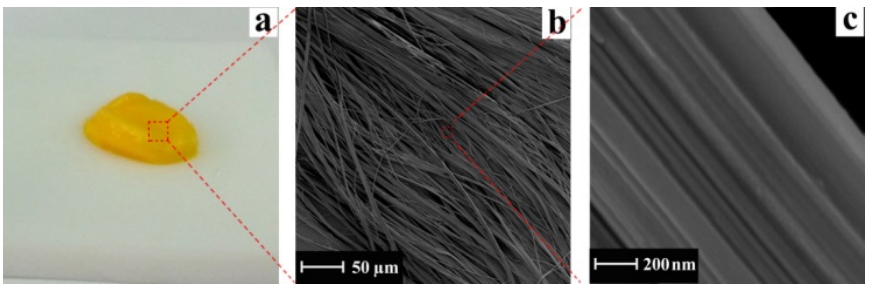
Figure 8. C4-Azo-C5-HDA gel (20 °C) in water at 5 wt%: ( a ) photograph of the gel, ( b ) SEM image and ( c ) SEM image.